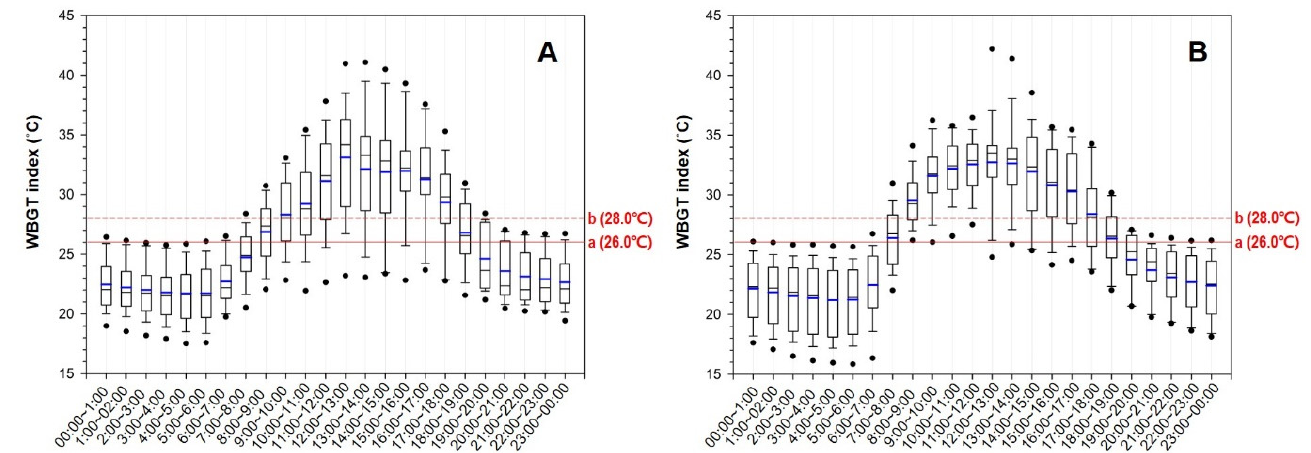
Figure 4. Wet-bulb globe temperature (WBGT) index inside greenhouses over an hourly interval (June–September in 2020 ( A ) and 2021 ( B )) with reference lines for moderate work, as defined by ISO 7243, including a solid line, (a), showing the reference limit for persons not acclimatized to heat, and a dashed line, (b), showing the reference limit for persons acclimatized to heat.